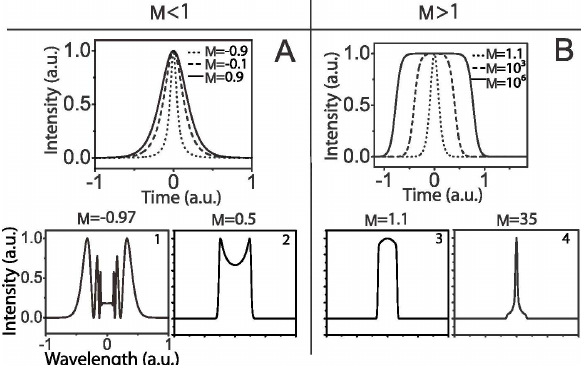
Figure 4: The temporal profiles (top) and spectra (bottom) of typ- ical dissipative solitons categorized by the value of M . (Adapted from